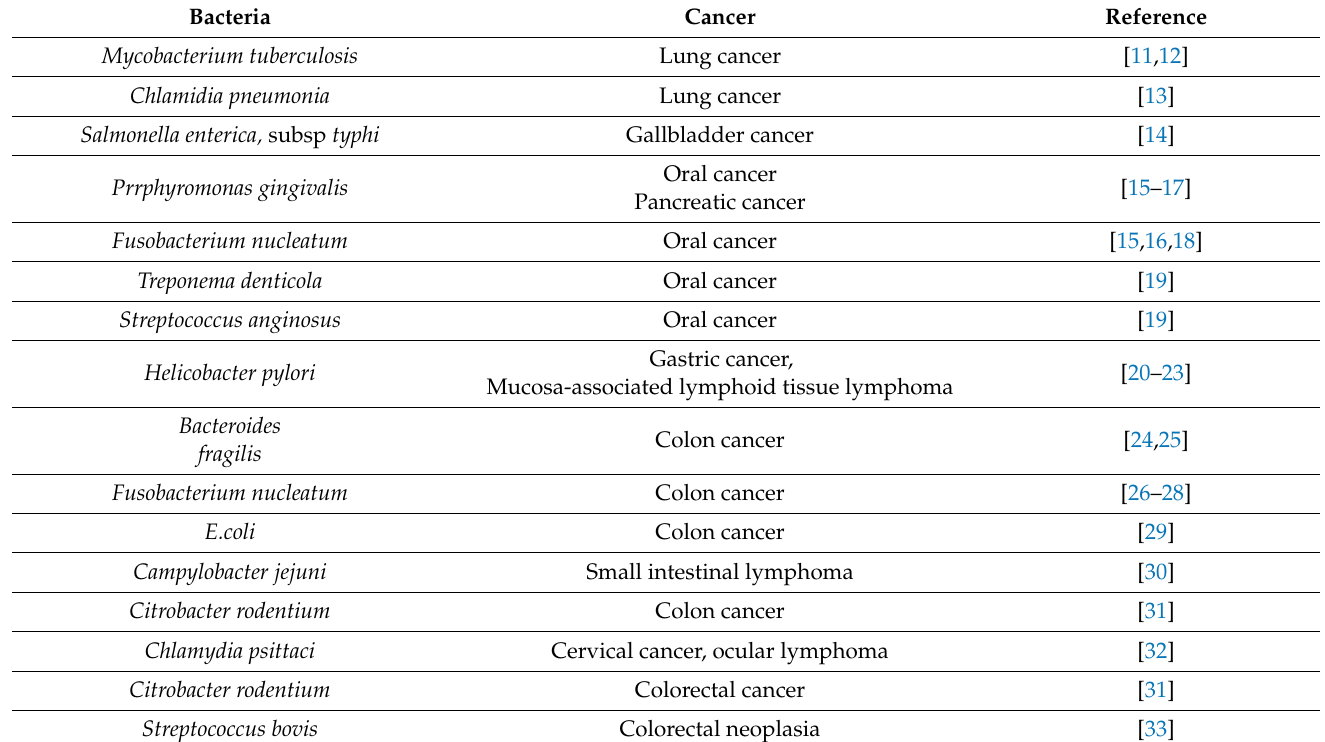
Table 1. Cancers induced by bacterial